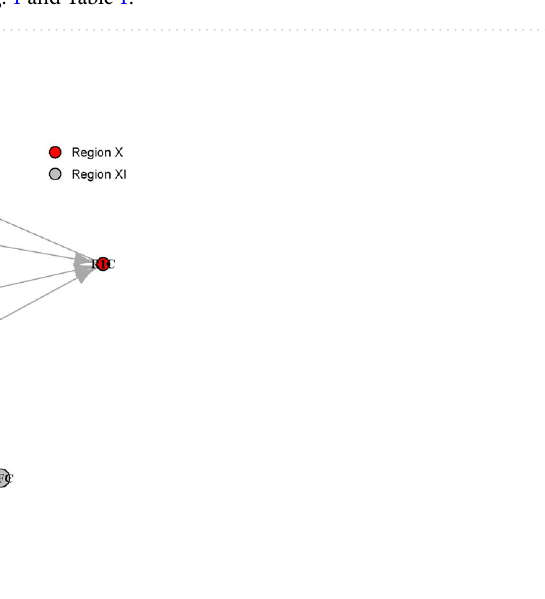
Figure 3. Sequential cluster analyses of D. dianthus individuals using Structure Selector and CLUMPAK. The clusters K = 2 presented the lowest negative value of mean (LnProb): − 20,875.091 (for details, see Supplementary Fig. S2). C_ = Comau Fjord, R_ = Reñihue Fjord, P_ = Pitipalena Fjord, GP_ = Gulf de Penas, AG_ = Archipelago Guayaneco. For complete locality names, see Fig. 1 and Table 1.